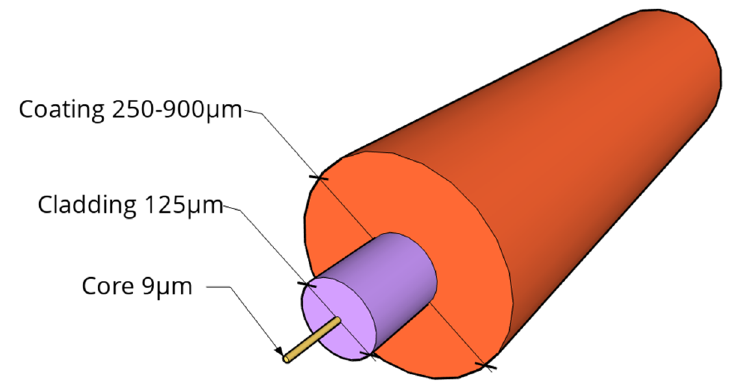
Figure 1. 3D illustration of an optical fiber cross-section.